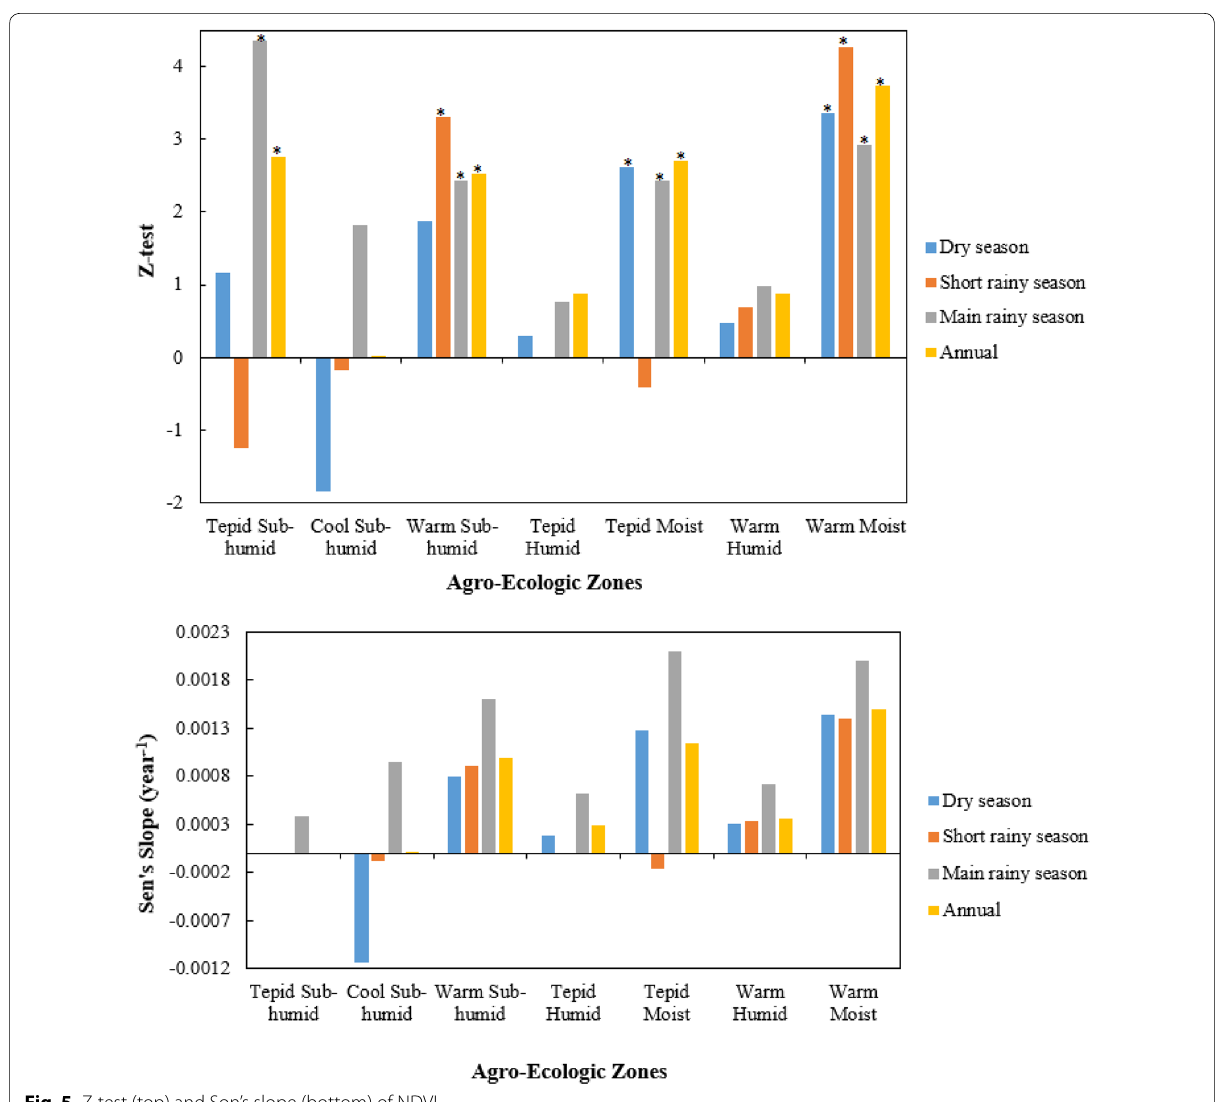
Fig. 5 Z-test (top) and Son’s slope (bottom) of